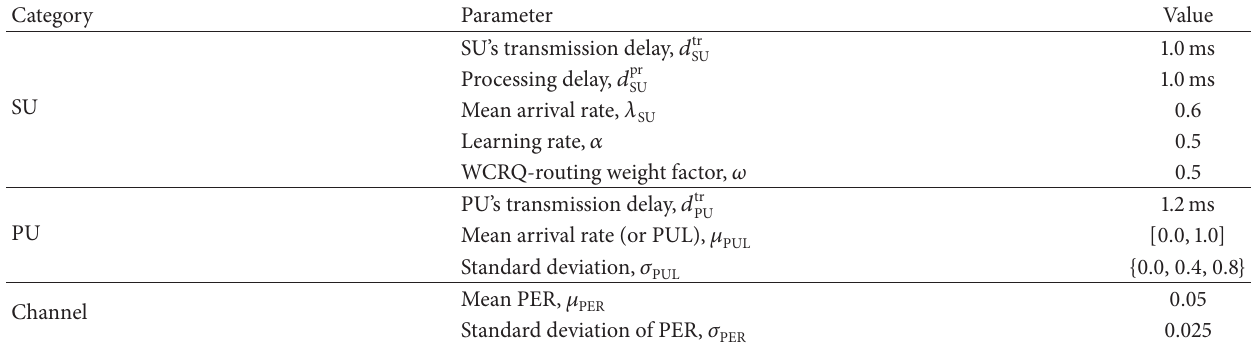
Table 3: Simulation parameters and